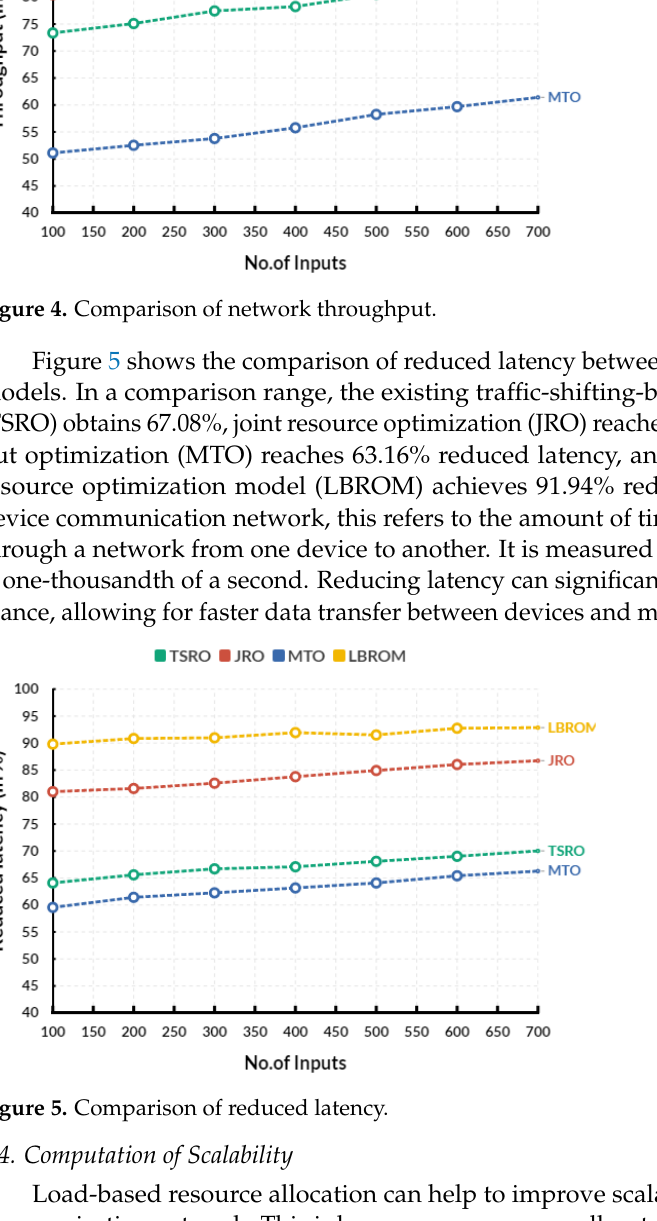
14 of 19 Figure 3. Comparison of network efficiency. 5.2. Computation of Throughput By allocating resources to devices based on the current load, load -based resource allocation can increase the overall throughput of the network. This is because more re- sources are given to devices that require them, resulting in better overall performance. The network throughput can be computed with the help of the following Eq uation (14) : 1.2 × 